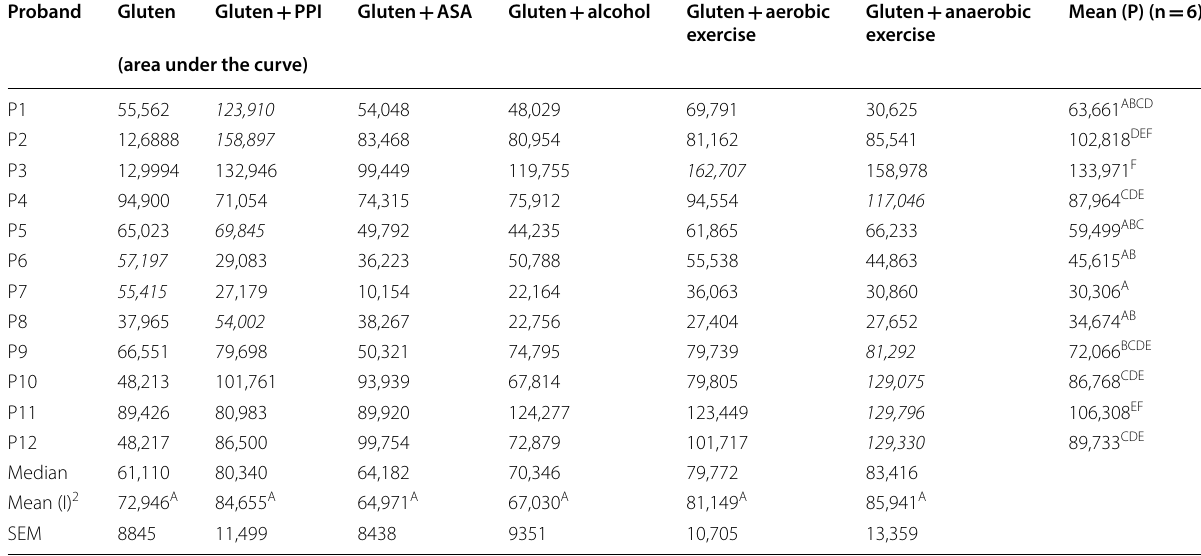
Values in italics designate the highest AUC for each proband ASA acetyl salicylic acid, PPI proton pump inhibitor, SEM , standard error of the mean 1 Mean (P) designates the mean AUC of all six interventions per proband displayed per row. Different superscript capital letters indicate significant differences between means (P) of probands (two-way ANOVA, Tukey’s test, p < 0.001); 2 Mean (I) designates the mean AUC of all twelve probands per intervention displayed per column. There were no significant differences between means (I) (two-way ANOVA, Tukey’s test, p superscript capital letter